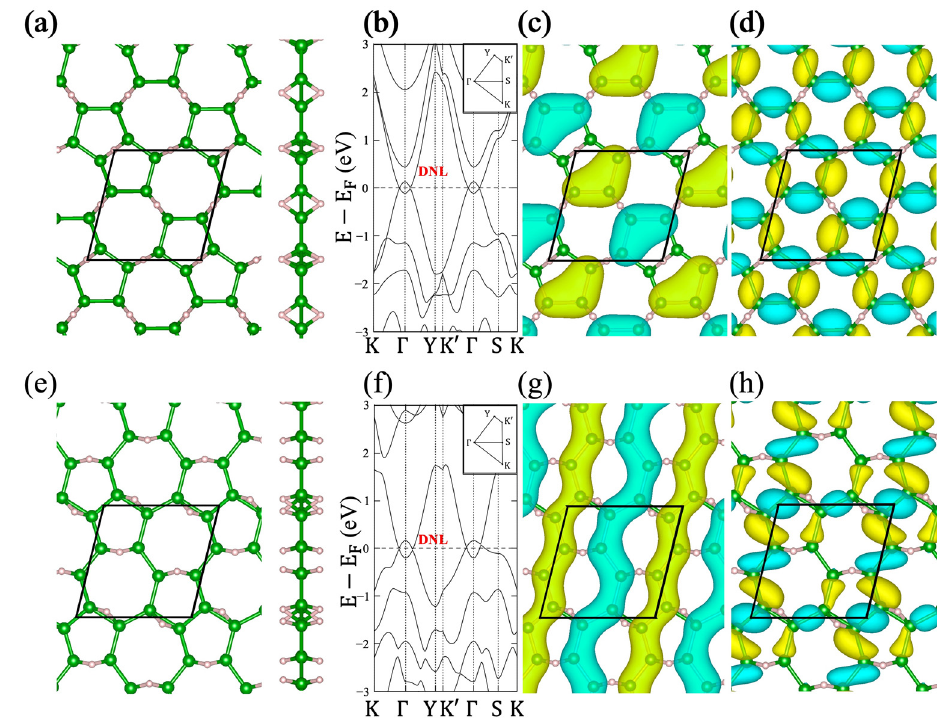
Figure A2. The β borophane. The β 1 -type: ( a ) atomic structure, ( b ) band diagram, ( c ) π wave functions (lower bands of a DNL), and ( d ) σ wave functions (higher bands of a DNL). The β 2 -type: ( e ) atomic structure, ( f ) band diagram, ( g ) π wave functions (lower bands of a DNL), and ( h ) σ wave functions (higher bands of a DNL). The color of each molecular orbitals corresponds to the sign of its wave functions. The unit cell is represented as a rhombus in each subfigure corresponding to the atomic structures and orbitals. The letters shown in (b) and (f) represent the high symmetry points in the first Brillouin zone shown as insets of (b) and (f).